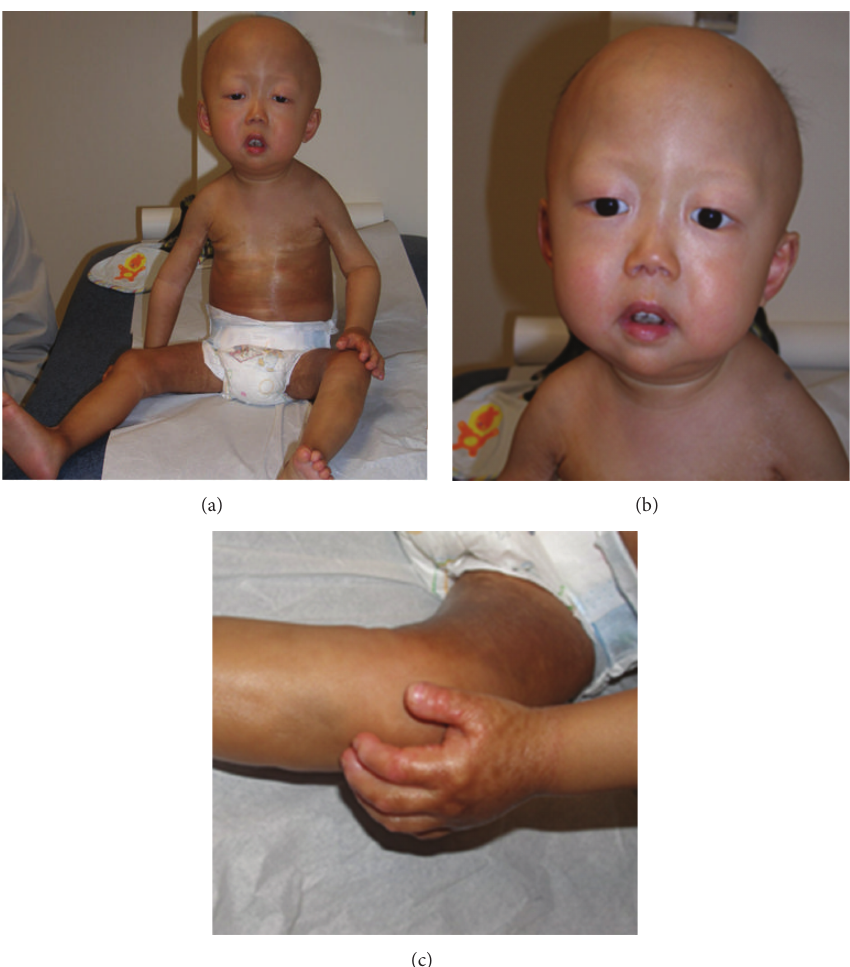
Figure 1: Clinical features of the patient with a homozygous mutation p.M540T. (a) presents proband’s hyperpigmented and thickened skin (especially on his truck and thighs) and thin clavicles. (b) depicts patient’s prominent cranium and the loss of hair. (c) demonstrates his small contracted hands with bulbous distal